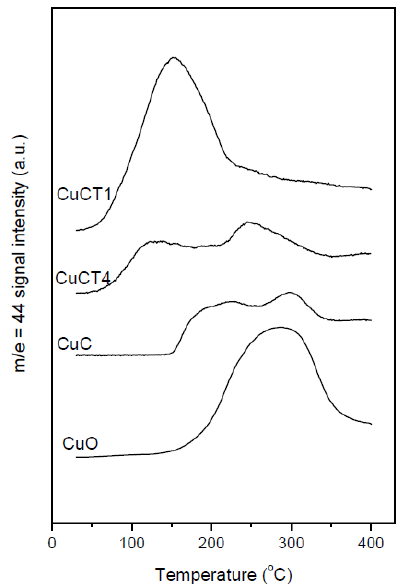
Figure 4. CO production during the CO-TPR runs performed with a tubular reactor over 2 the indicated samples. A CuO reference sample prepared by microemulsion has been included for comparative purpose. Note: This figure is reproduced with permission from [48]. Copyright © 2009, Elsevier